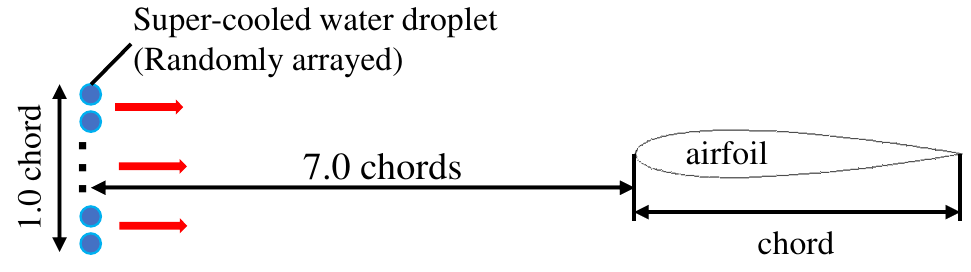
Figure 2. Schematics of droplet